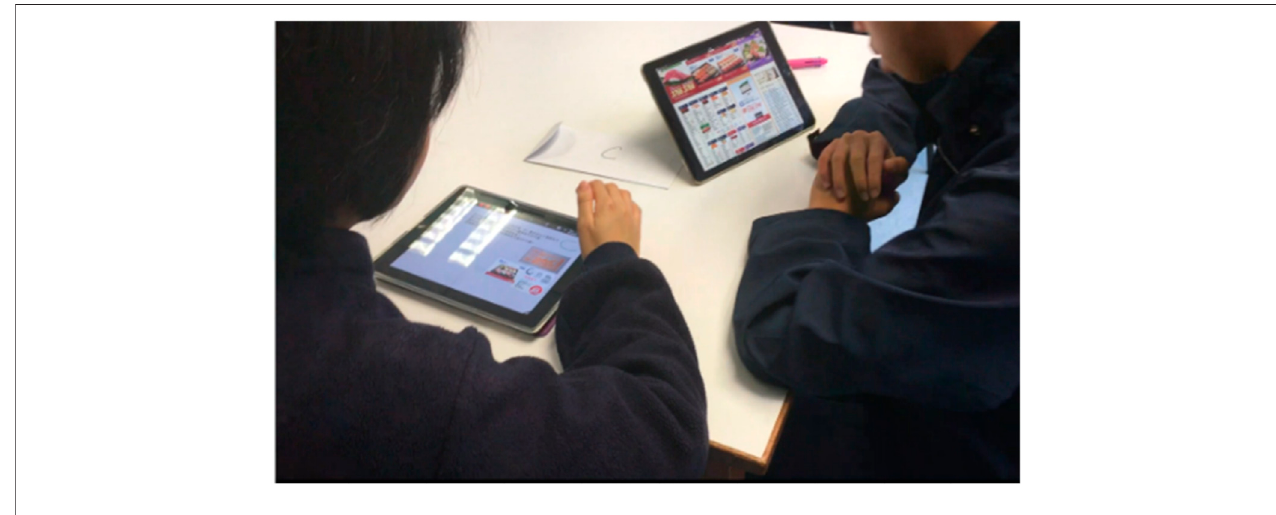
FIGURE 3 | Students checking up prices in fast food online shop.